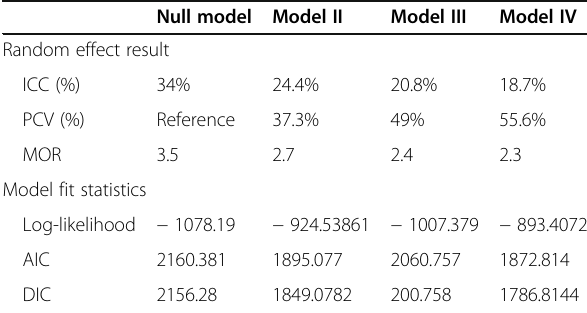
Table 5 Measures of variation (random intercept models) and model fit statistics in defaulting immunization among children aged from 12 to 23 months in EDHS